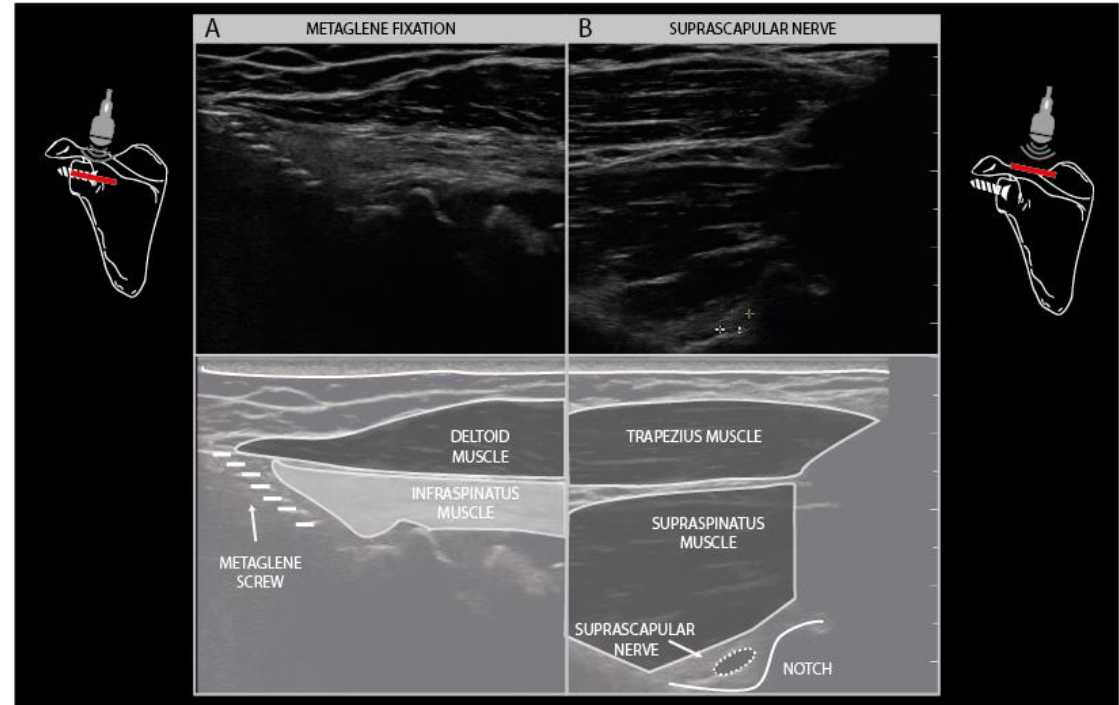
Figure 13. Reverse shoulder arthroplasty with metaglene fixation screw traction injury to the suprascapular nerve. Hy- perechogenic, denervated infraspinatus muscle layer underneath a normal appearing deltoid muscle ( A ). Suprascapular neuroma in continuity (3× normal size) at the level of the spinoglenoid notch ( B ).